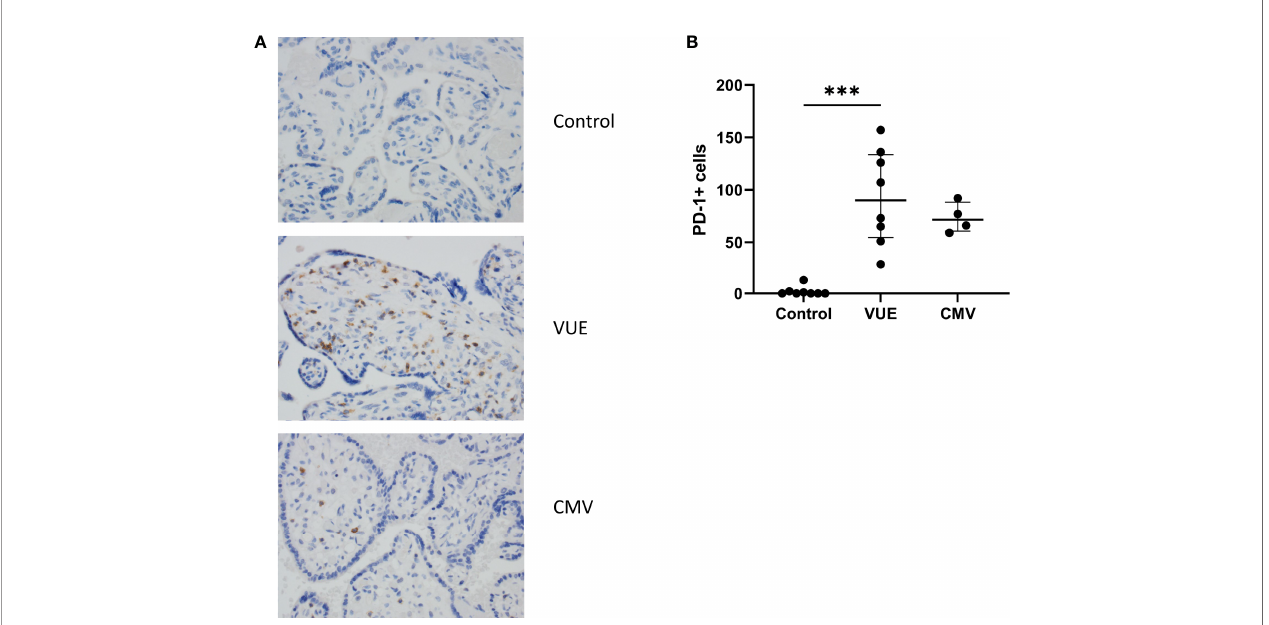
FIGURE 2 | PD-1+ cells in placentae with CMV, VUE and controls. (A) Representative PD-1 staining in all three groups (200X). (B) Average count of PD-1+ cells per 20 villi in control, VUE and CMV placentae. Graphs show median with interquartile ranges and signi fi cance was determined by Kruskal-Wallis testing with false discovery rate correction by Benjamini, Krieger and Yekutieli (n=4-8/group). ***p ≤